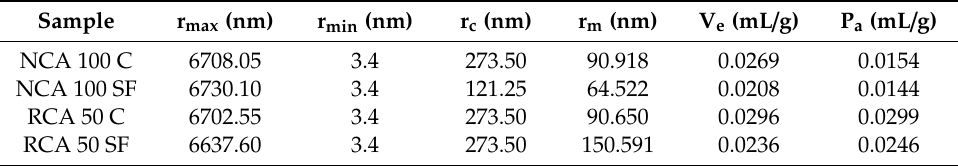
Table 6. Porous network indicators in Hg extruded stage.